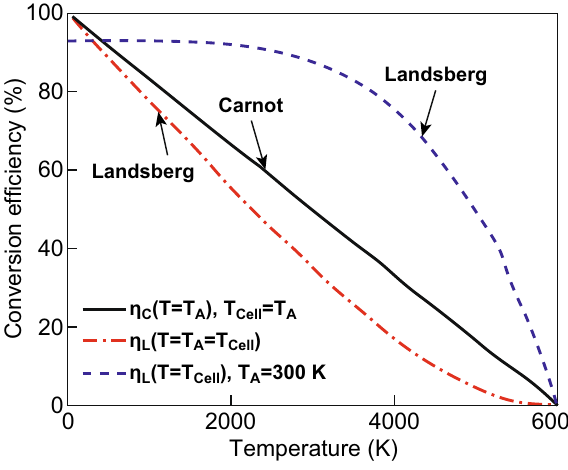
Fig. 4 Temperature dependent Carnot and Landsberg efficiencies for solar energy